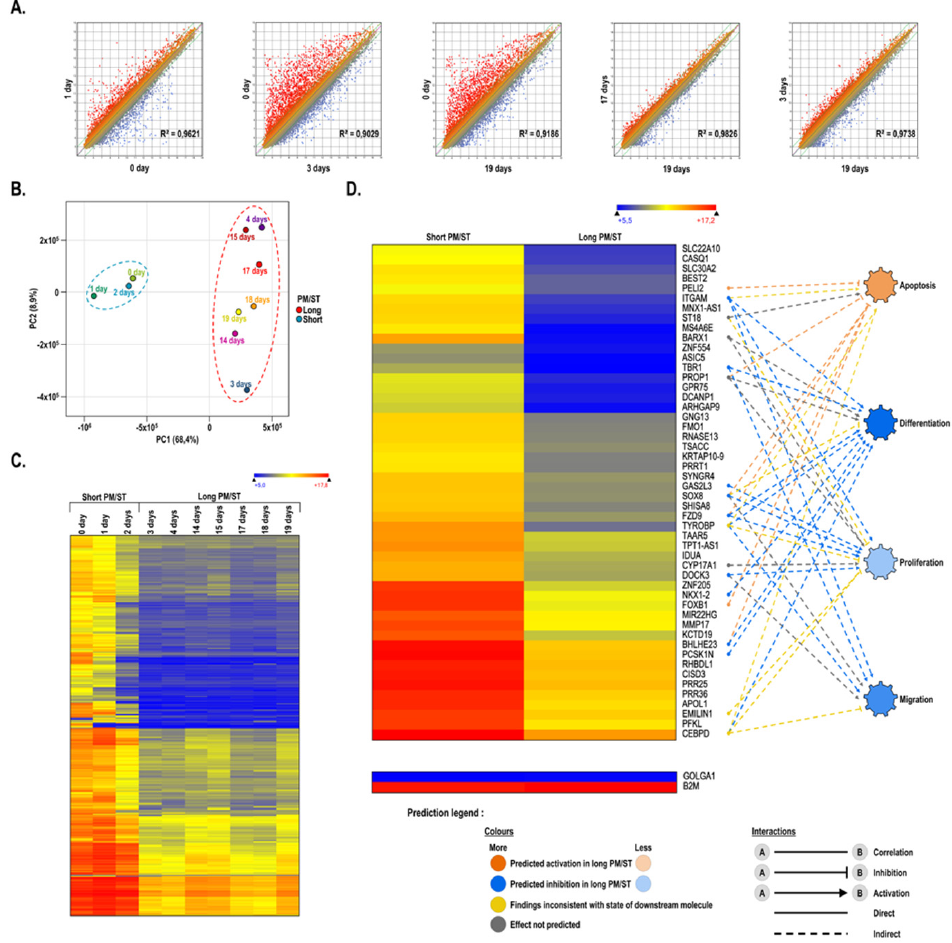
Figure 1. Alteration of gene expression patterns caused by the PM/ST of hLECs cultured in monolayer. ( A ) Scatter plots of log2 of signal intensity from 60,000 different targets covering the entire human transcriptome of hLECs with PM/ST 0, 3, and 19 days ( x -axis) plotted against hLECs with PM/ST 0, 1, 3, and 17 days ( y -axis). ( B ) Principal component analysis of gene expression patterns segregated 2 populations of hLECs: short PM/ST ( SPM/ST hLECs) and long PM/ST ( LPM/ST hLECs). As illustrated by the dotted ellipses, populations at 0, 1, and 2 days cluster together and differ from populations at 3, 4, 14, 15, 17, 18, and 19 days. ( C ) Heatmap representation of the 3-fold change, differentially regulated genes expressed by LPM/ST hLECs (long PM/ST: 3, 4, 14, 15, 17, 18, and 19 days) relative to their levels in SPM/ST hLECs (short PM/ST: 0, 1 and 2 days). ( D ) Heatmap representation of the 50 most differentially regulated genes expressed by LPM/ST hLECs relative to their levels in SPM/ST hLECs and their gene interaction networks based on IPA’s database and built around biological functions of interest. Data are also presented for the housekeeping genes β -2-microglobulin ( B2M ) and golgin A1 ( GOLGA1 ).